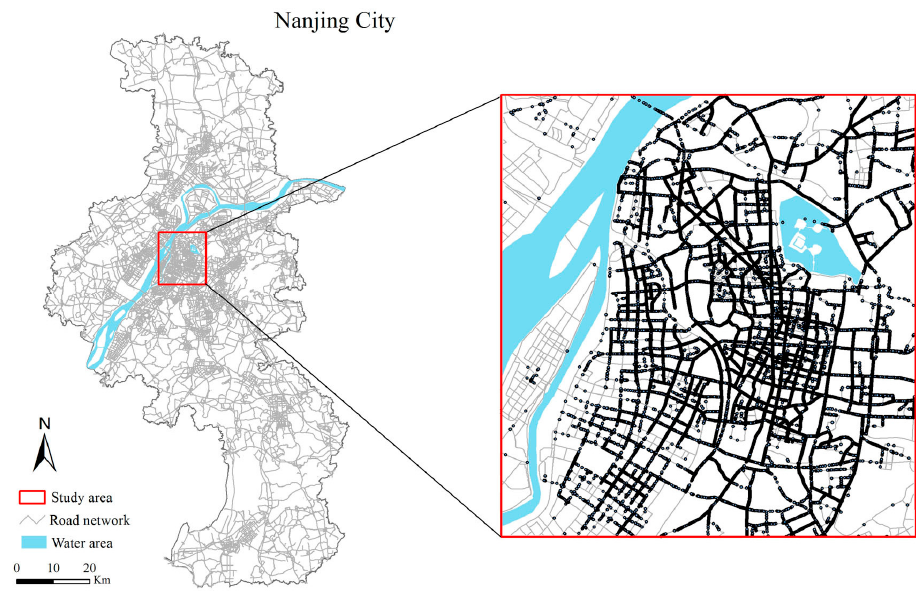
Figure 6. Study area with the pick-up and drop-off point events in Nanjing City.